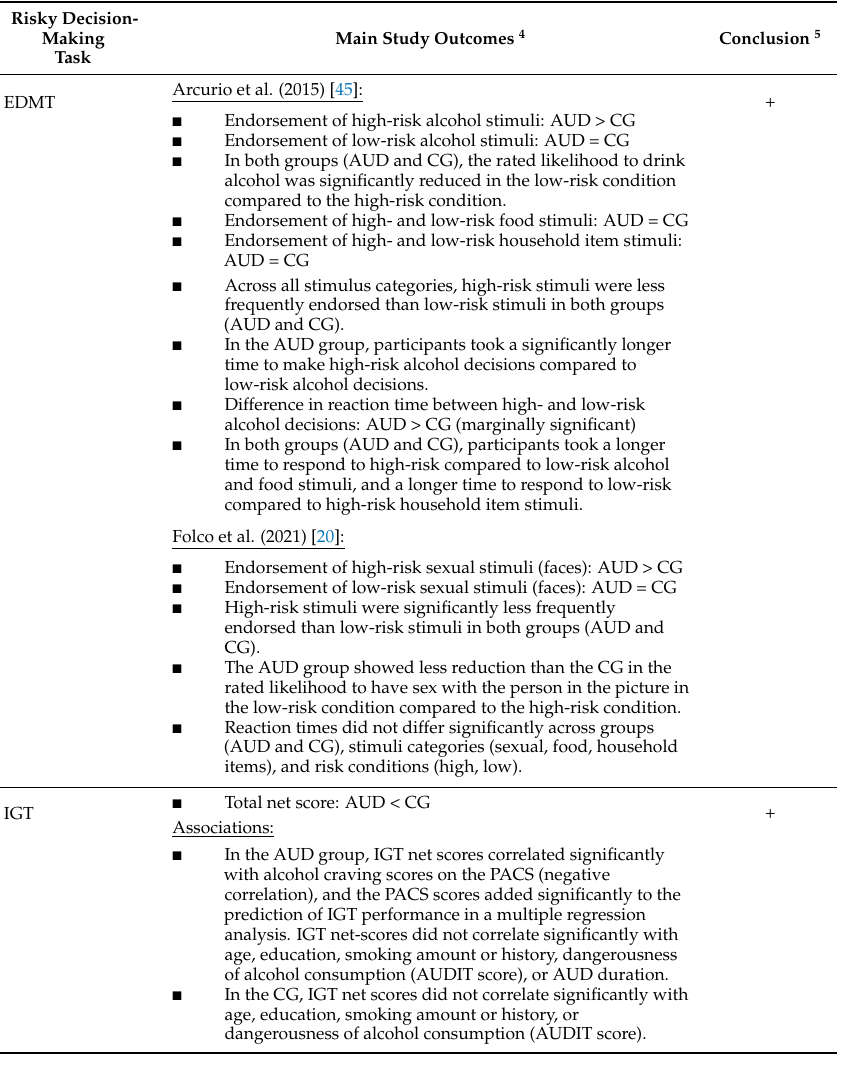
Table 2. Overview of included studies on risky decision-making in adults with